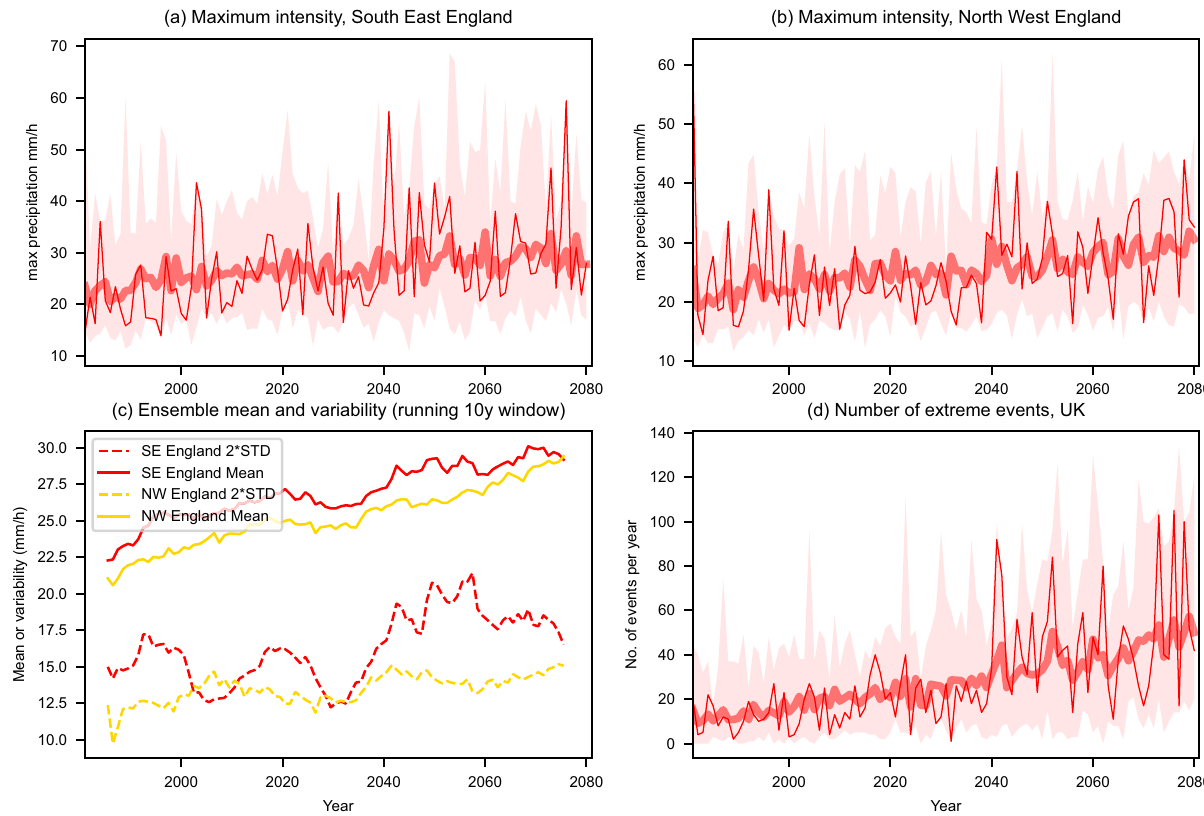
Fig. 3 | Evolution of hourly precipitation in the convection-permitting model. Shown is regional annual maximum hourly precipitation (mm/h) for a South-East Englandand b North-WestEngland,forthestandardmember(thinline),ensemble- mean (thick line) and ensemble min – max range (shaded), for hourly rainfall aver- aged over 12km grid box, for 1981 – 2080. c Running 10-year multi-member mean (solid) and variability (standard deviation scaled by 2, 2*STD, dashed) in regional